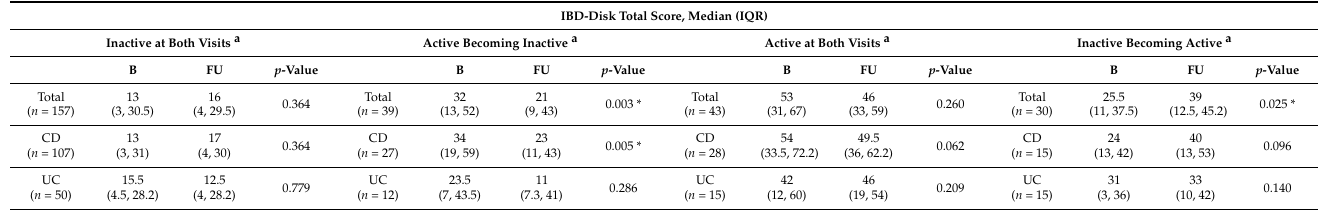
Table 4. Change in the IBD-Disk total score between baseline and follow-up ( n =